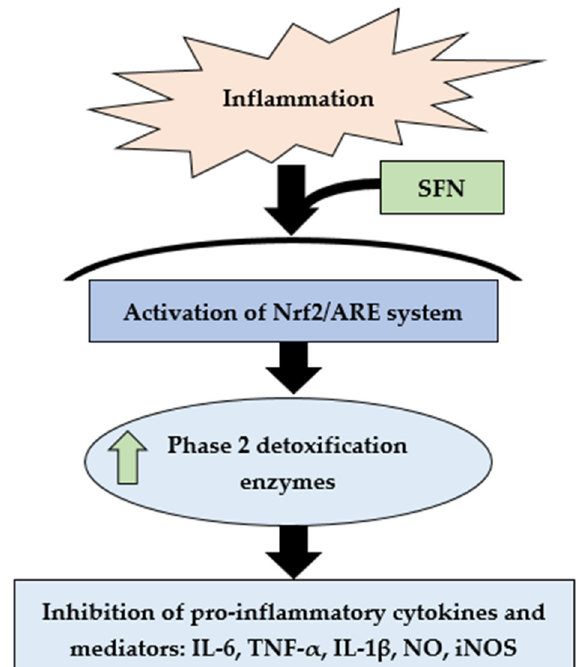
Figure 6. Summary of SFN-mediated activation of Nrf2/ARE-driven phase 2 detoxifying enzyme expression and potential inhibition of pro-inflammatory cytokines and other mediators.